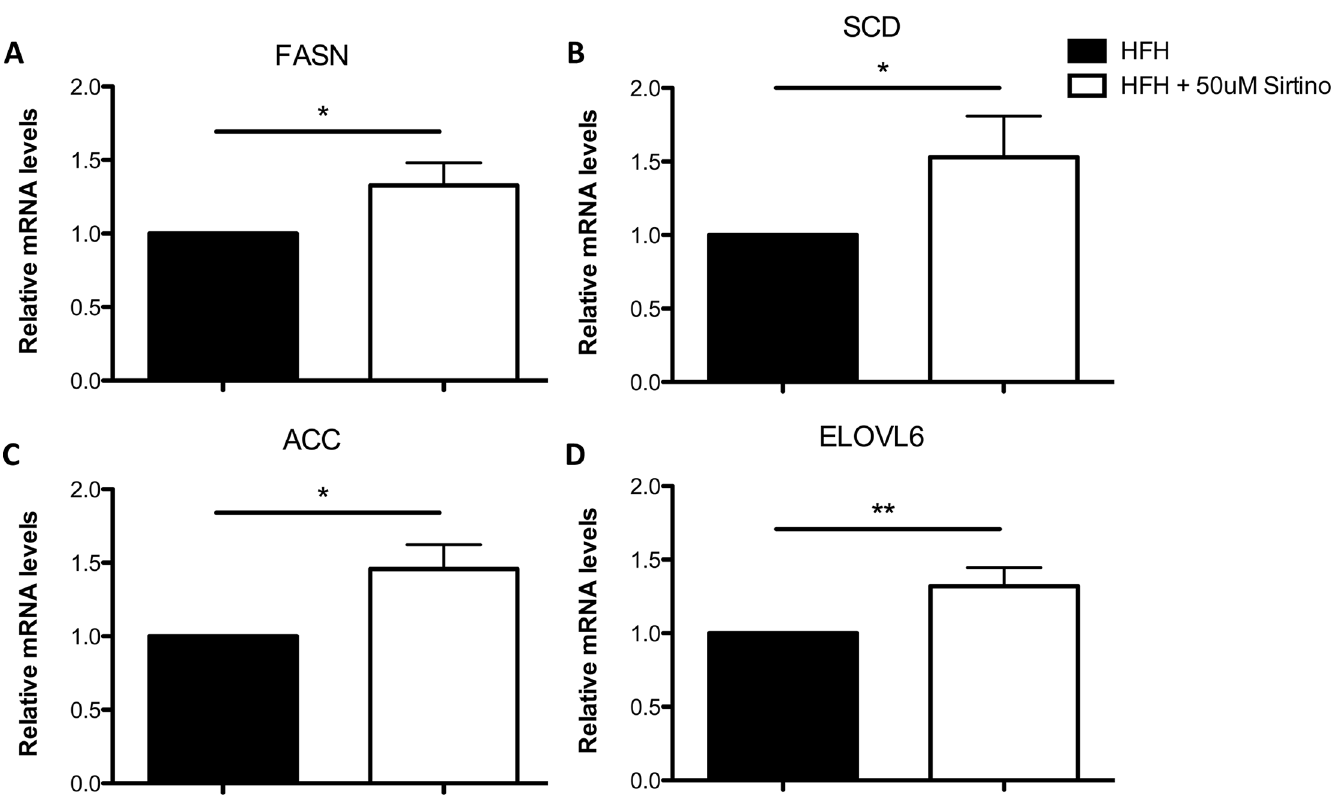
Fig 3. Increased activation of De Novo Lipogenesis related genes in human fetal hepatocytes after Sirt1 inhibition. Expression of hepatic FASN, SCD, ACC and ELOVL6 mRNA measured by qRT-PCR in human fetal hepatocytes exposed to +50uM Sirtinol compared to controls. (N (cid:1) 7/group; * , P < .05)